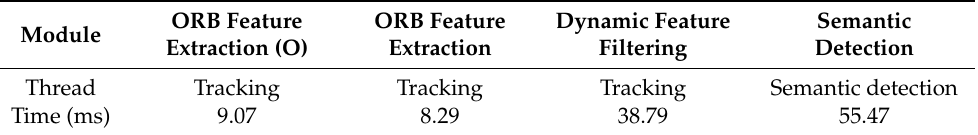
Table 5. Results of the operational e ffi ciency